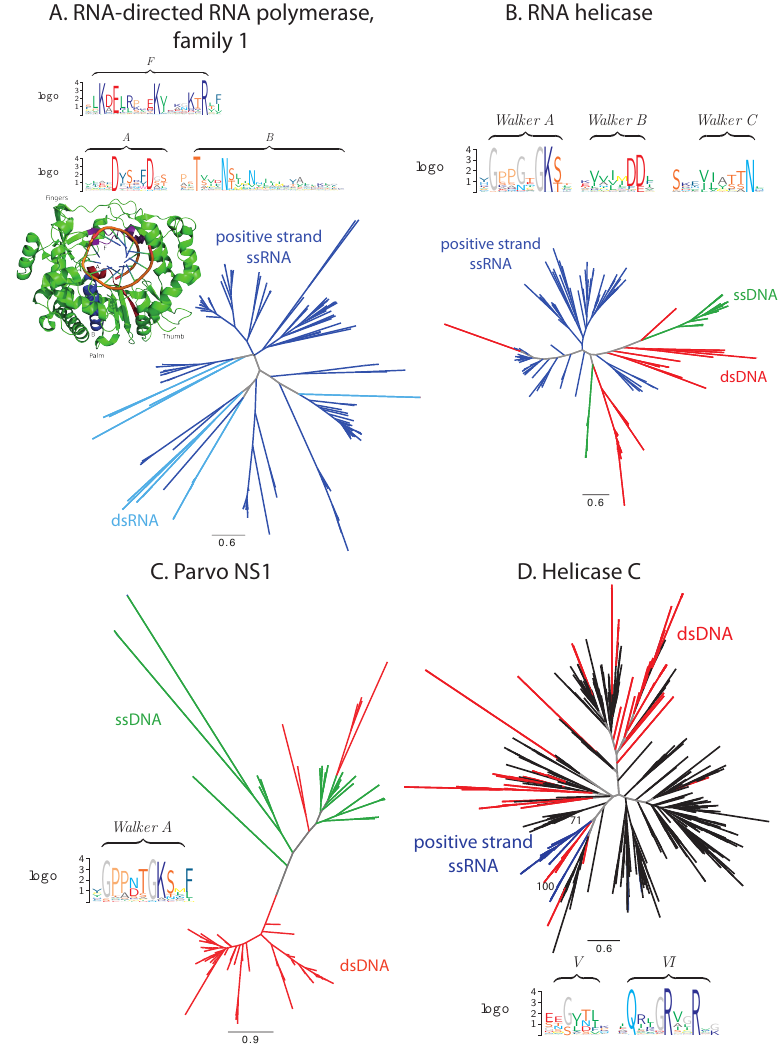
Figure 1. Phylogenetic and conservation analysis in families with balanced sequence distribution. ( A ) RdRP family 1; ( B ) RNA helicase family; ( C ) parvo NS1 family; ( D ) helicase C family. Branches corresponding to dsDNA viruses are colored red, ssDNA viruses green, positive-strand RNA viruses blue, ssRNA viruses cyan, proteins from cellular organisms in black and internal branches that do not lead to proteins from monophyletic clades in gray. Functional motifs and catalytic sites are presented in sequence logos and protein 3D structure, where appropriate (discussed in the